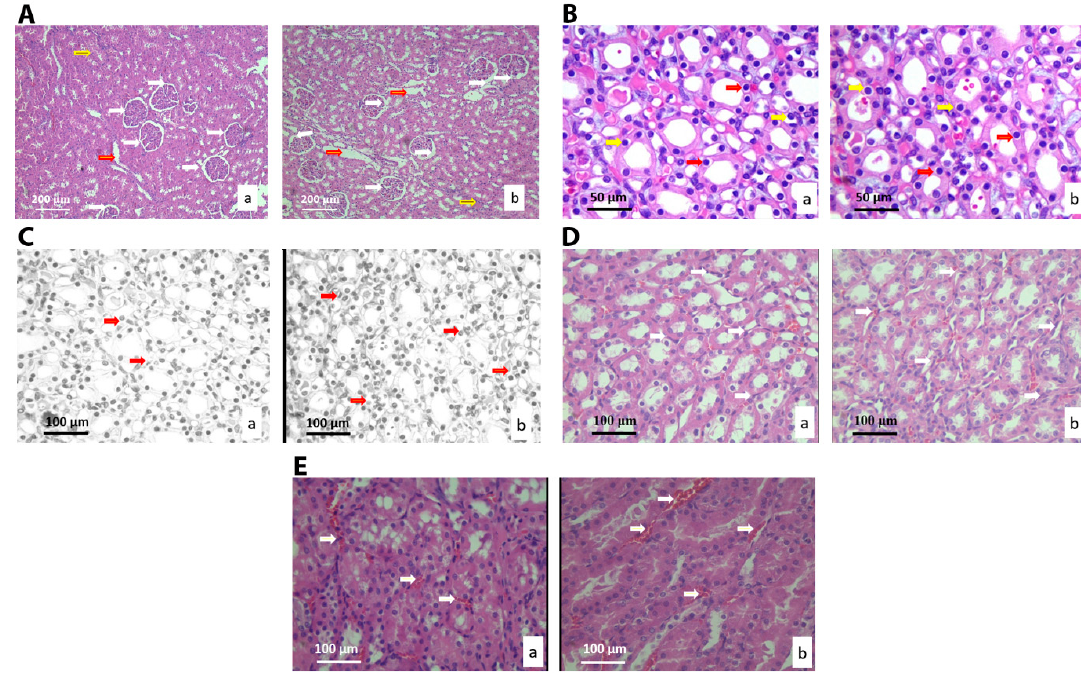
Figure 4. Micrographs of histological cross-sections of the kidney of the control ( a ) and treated group ( b ), (H&E). ( A ) White arrows show glomeruli, red arrows show blood sinusoids and yellow arrows show connective tissue. Magnification 20 × ; ( B ) Yellow arrows show nuclei, and red arrows show epithelial cells of collecting ducts. Magnification 50 × ; ( C ) Red arrows show the epithelial cells of collecting ducts. Magnification 50 × ; digitally processed RGB technique; ( D ) White arrows show the connective tissue of collecting ducts. Magnification 50 × ; and, ( E ) White arrows show the blood sinusoids of the collection ducts. Magnification 100 × .